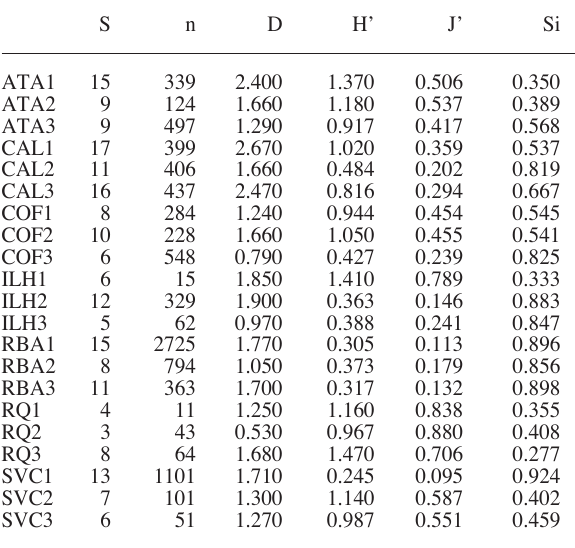
T ABLE 3. – Species richness (S), total number of molluscs per site (n), diversity indices of Margalef (D), Shannon-Wiener (H’) and Pielou (J’), Simpson’s dominance index (Si). Other abbreviations as in Figure